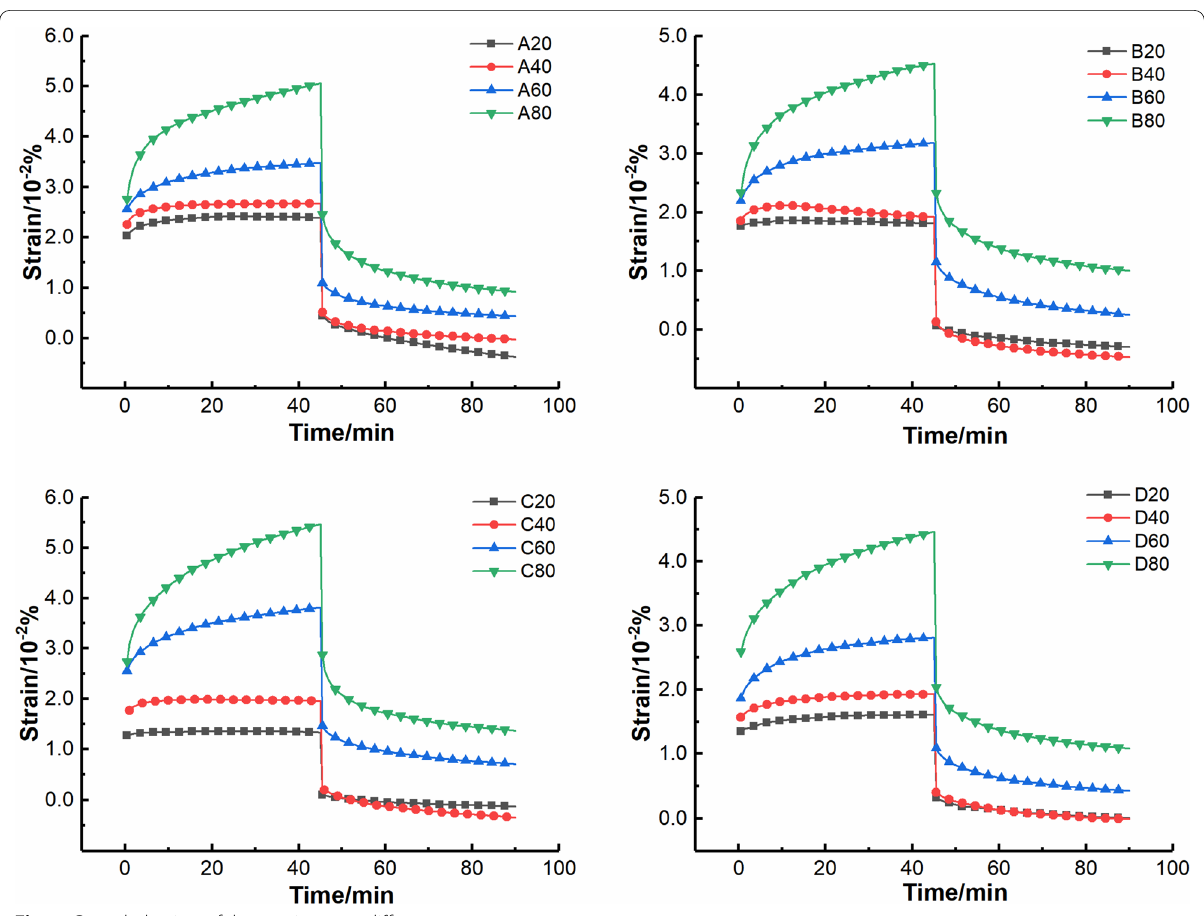
Fig. 4 Creep behaviors of the specimens at different temperatures